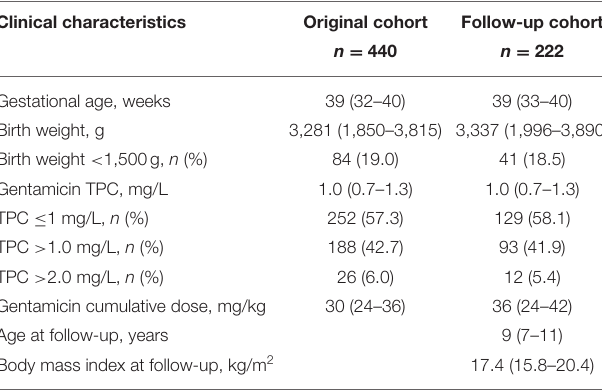
TABLE 2 | Comparison of clinical characteristics and gentamicin exposure in the original cohort and the follow-up cohort. Clinical